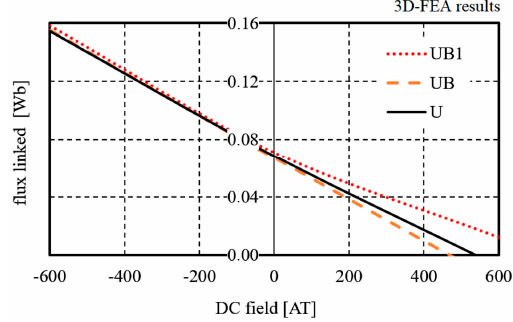
Figure 4. Characteristics of magnetic flux linkage Ψ s versus DC field excitation.